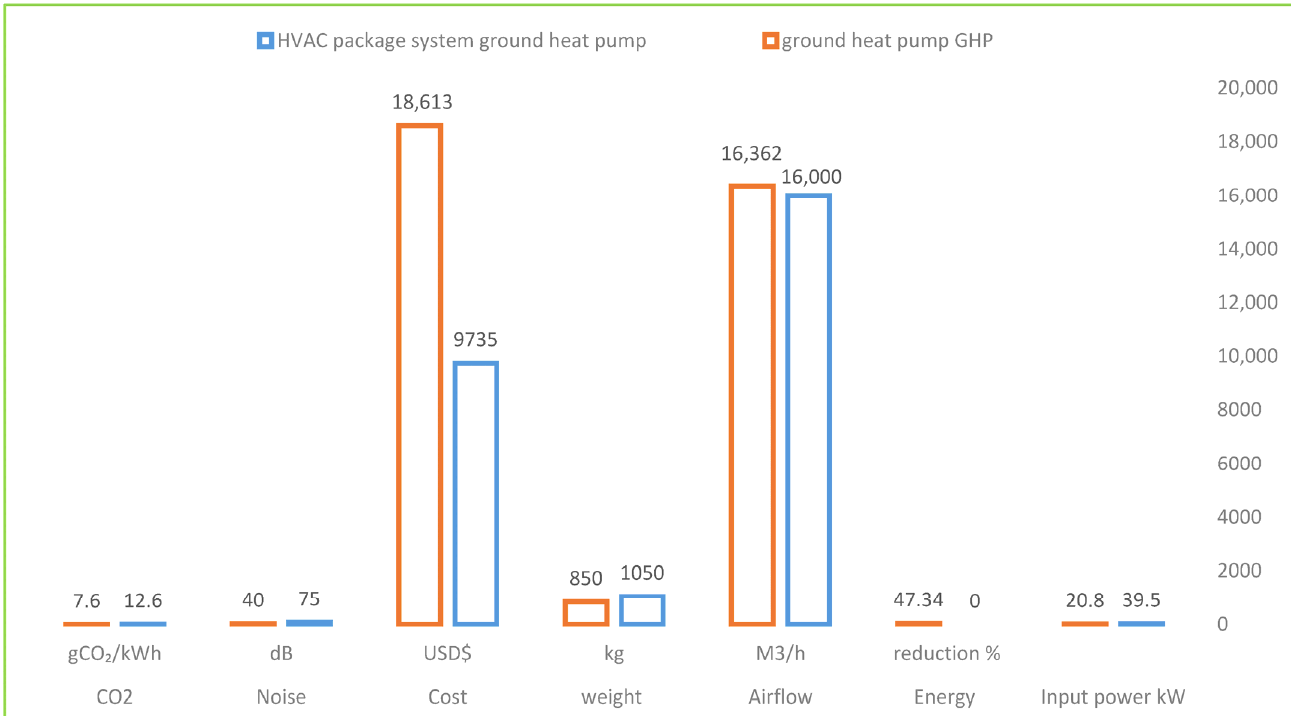
Figure 6. Data comparison for the GHP system and HVAC package system.